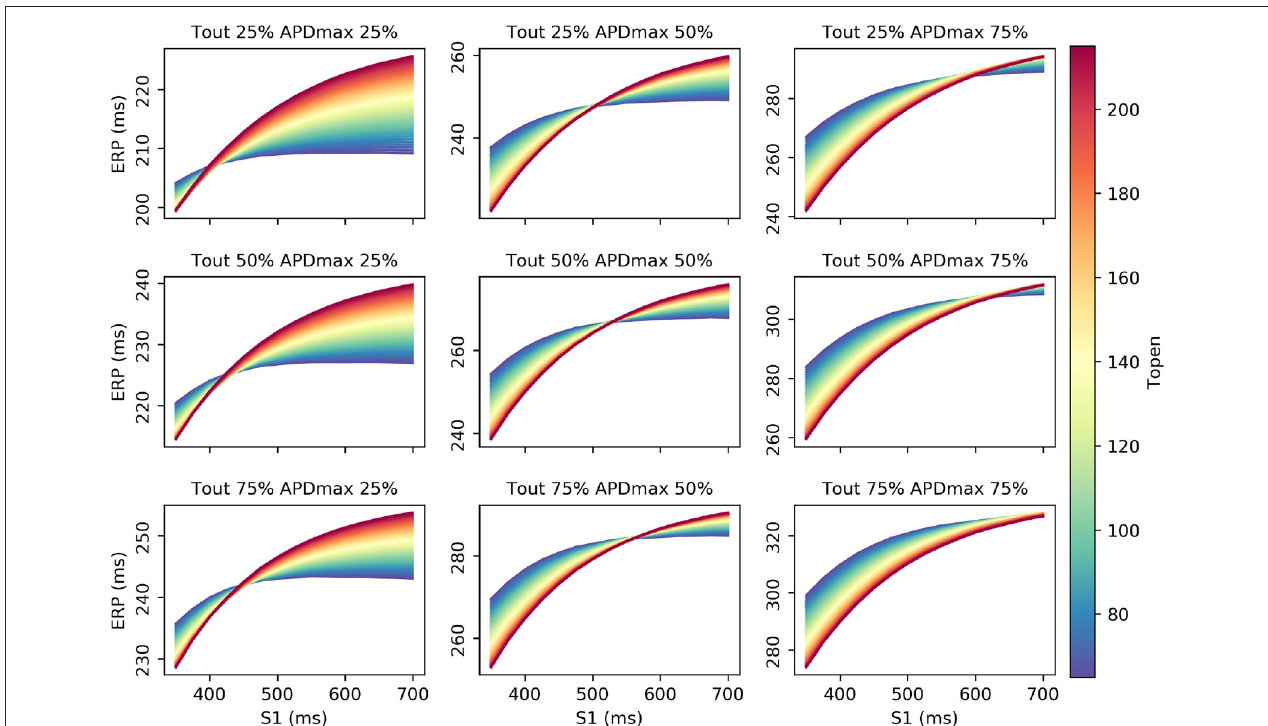
FIGURE 7 | RCE predictions to explore the effects of τ open on ERP(S1) across the parameter space.